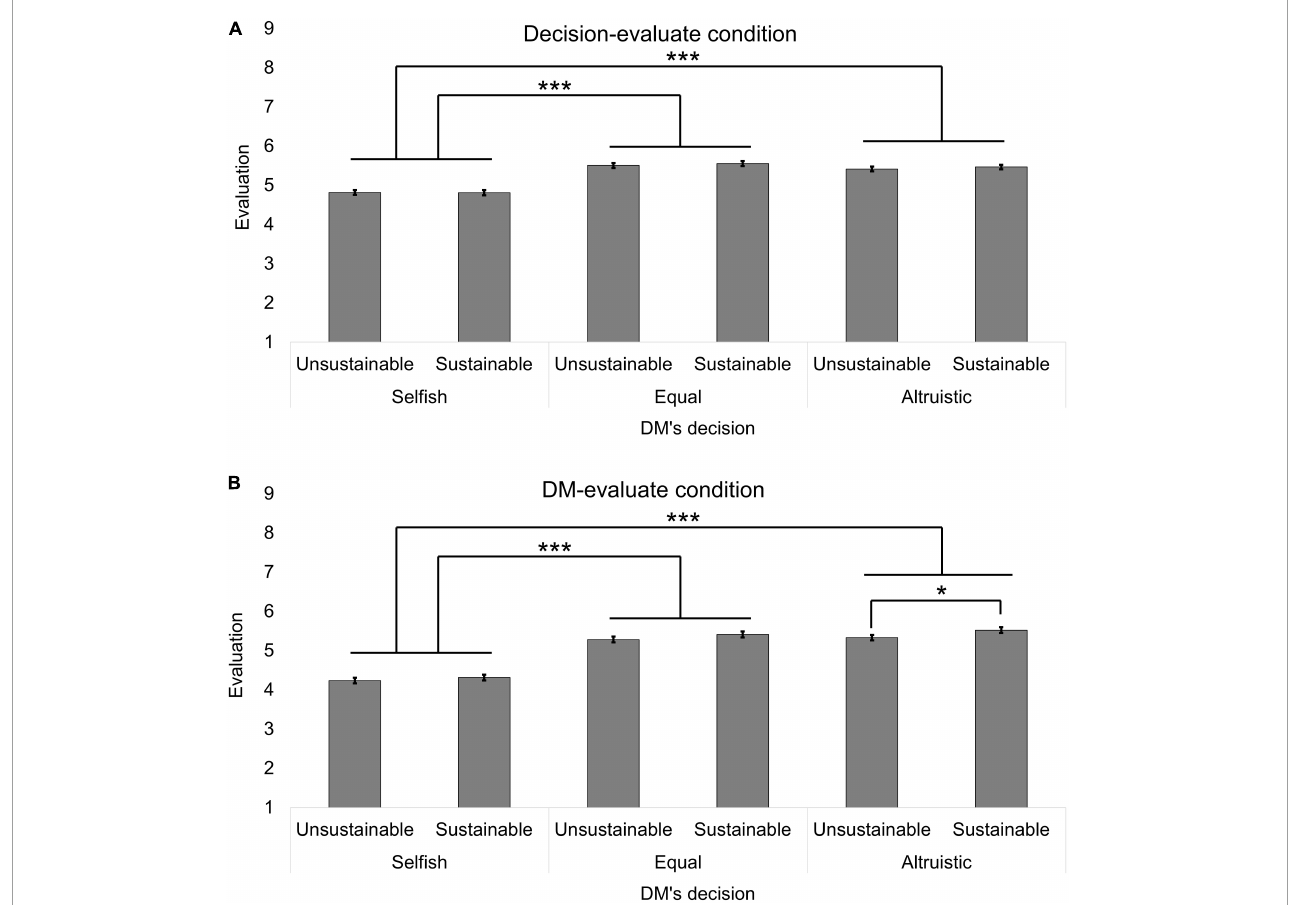
FIGURE3 The evaluation in the three intragenerational allocation conditions other than the no-decision condition (Study 1). (A) Is the evaluation in the decision-evaluate condition. (B) Is the evaluation in the DM-evaluate condition. Error bars represented the standard errors. Different from the main text, sample means were shown. The asterisks indicate Holm-corrected statistical significance based on the simple main effect analysis of the sub-sample. * p < 0.05, *** p < 0.001.